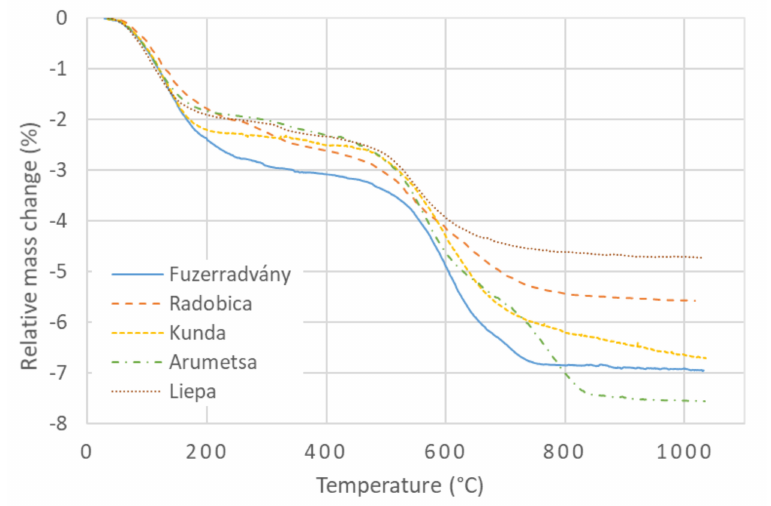
Figure 1. Relative mass change of investigated